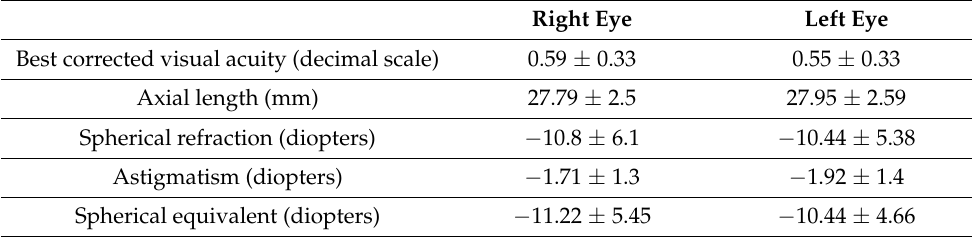
Results are presented as mean ± standard deviation.